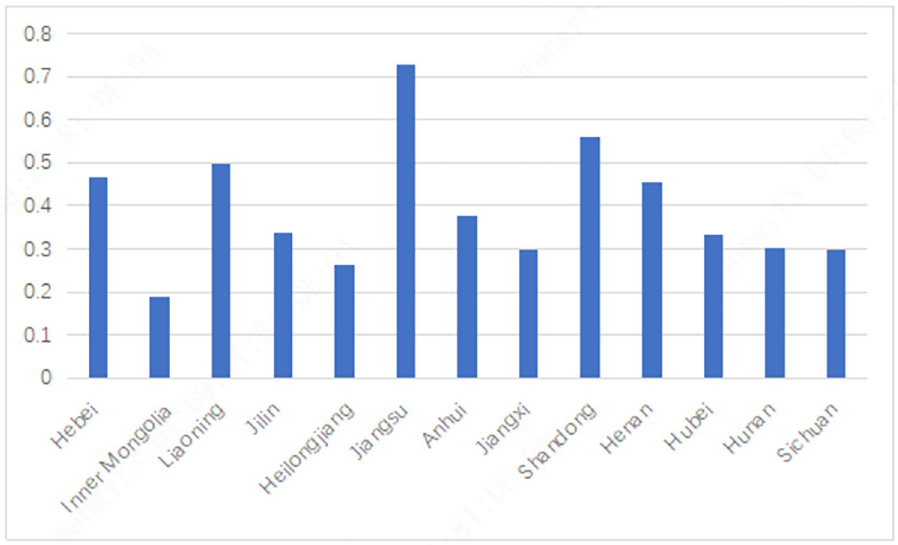
which is 0.7275; Inner Mongolia has the lowest score of Index of Financial Inclusion, which is 0.1874.